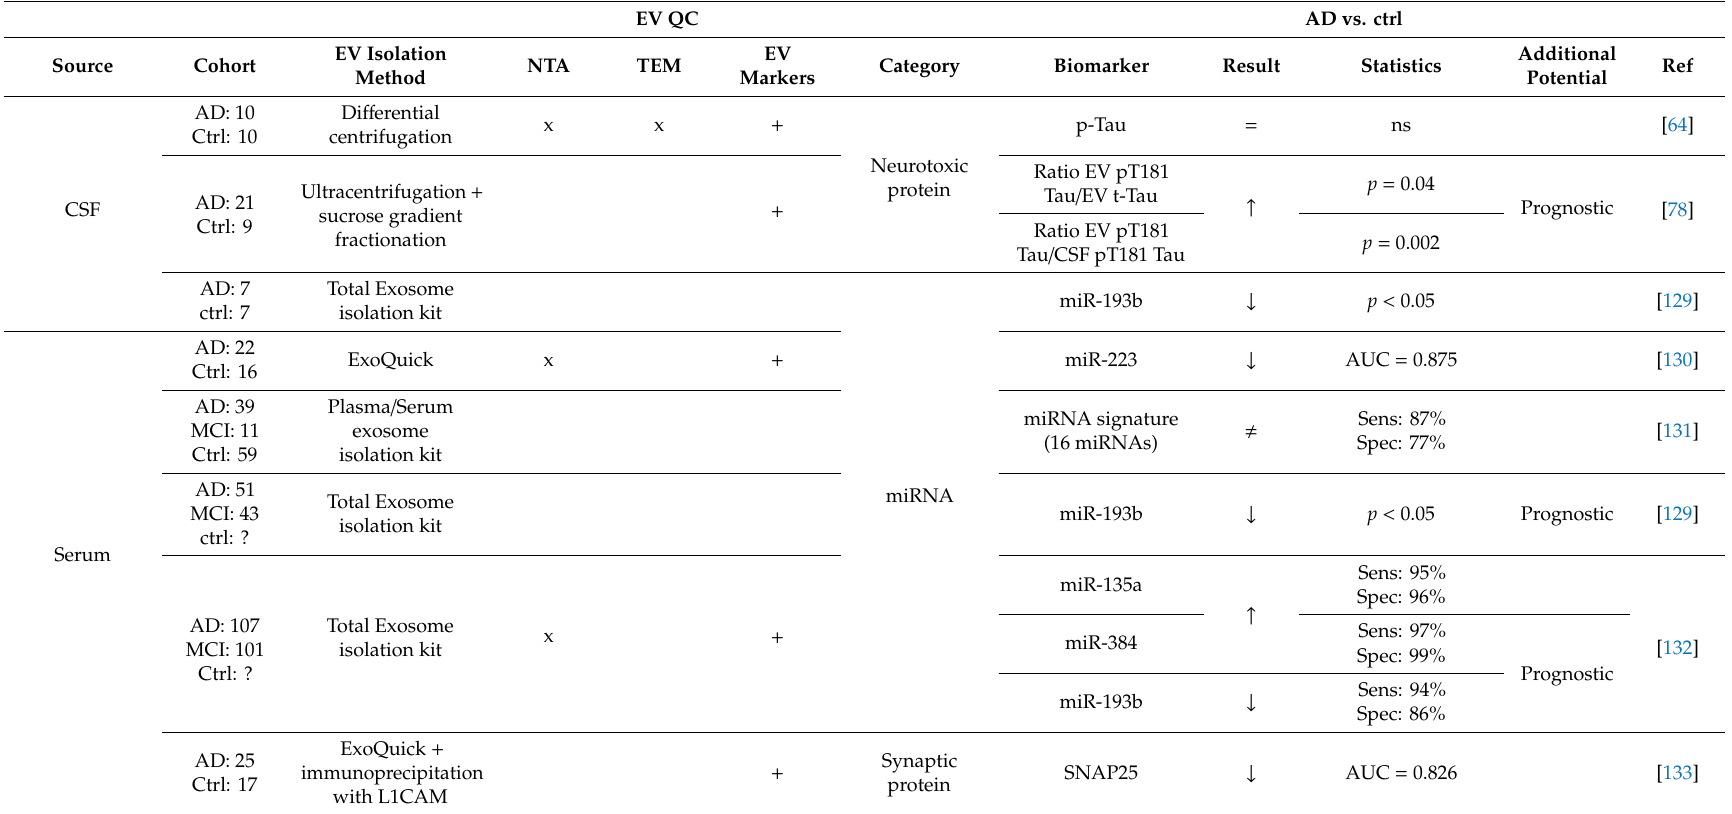
Table 1. Overview of extracellular vesicle (EV)-associated biomarkers in Alzheimer’s disease (AD). EV QC AD vs. ctrl